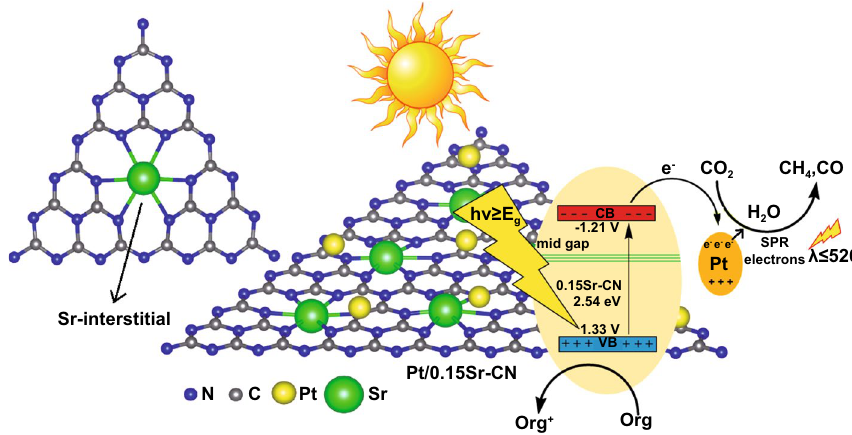
Fig. 10 Schematic of the energy band-structure, charge separation and transfer and the surface redox reactions over the Pt/0.15Sr-CN